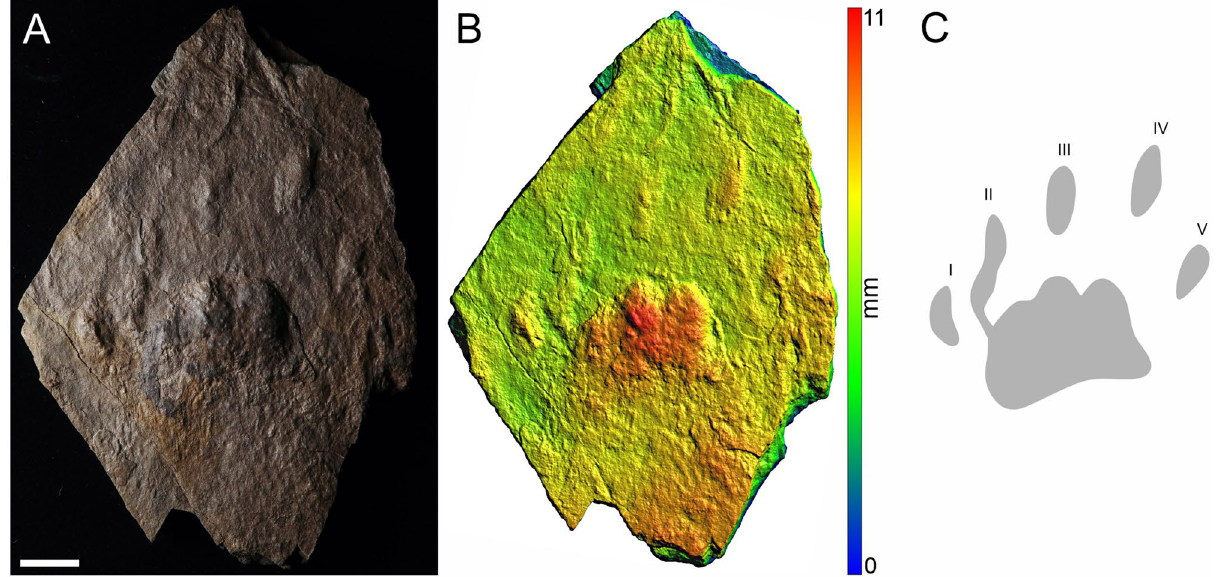
Figure 6. The track of MZM Ge 33071 convex hyporelief ( A ), image ‐ based modeling ( B ), and the outline drawing ( C ). Scale bar 2